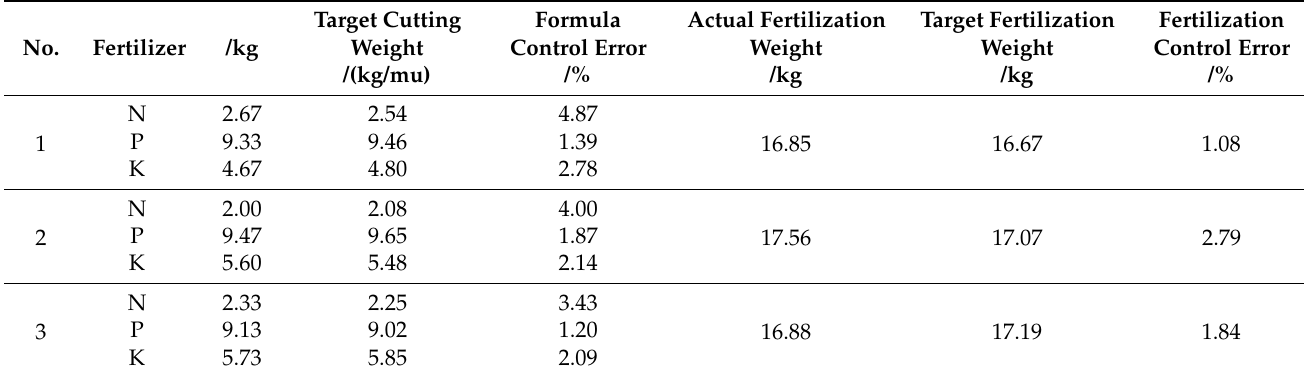
Table 4. Test to verify measurement results.